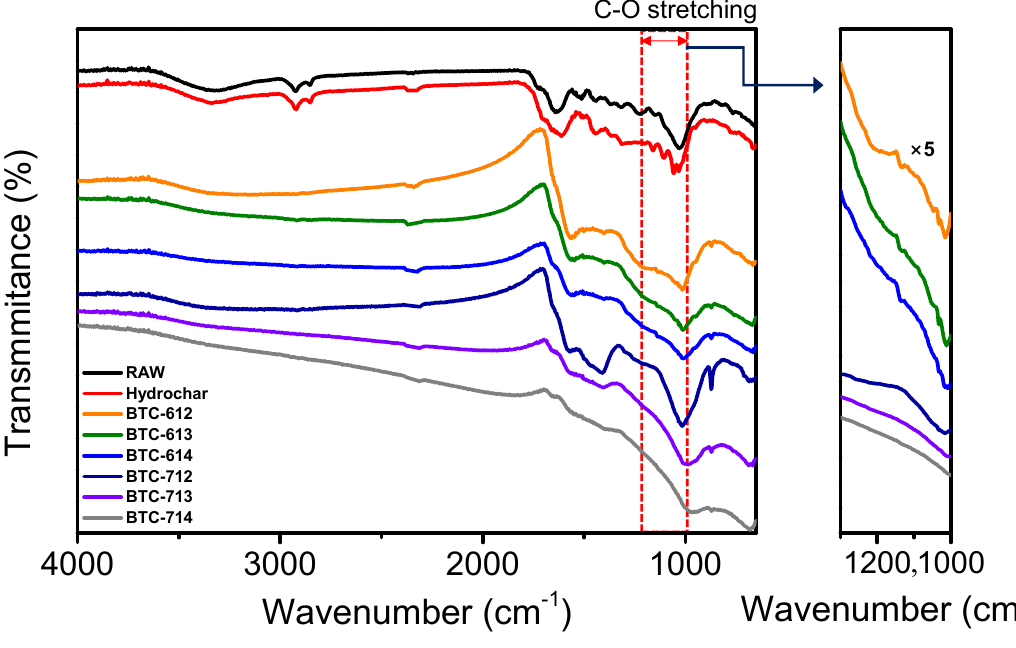
Figure 5. FT-IR spectrum of BTCs.